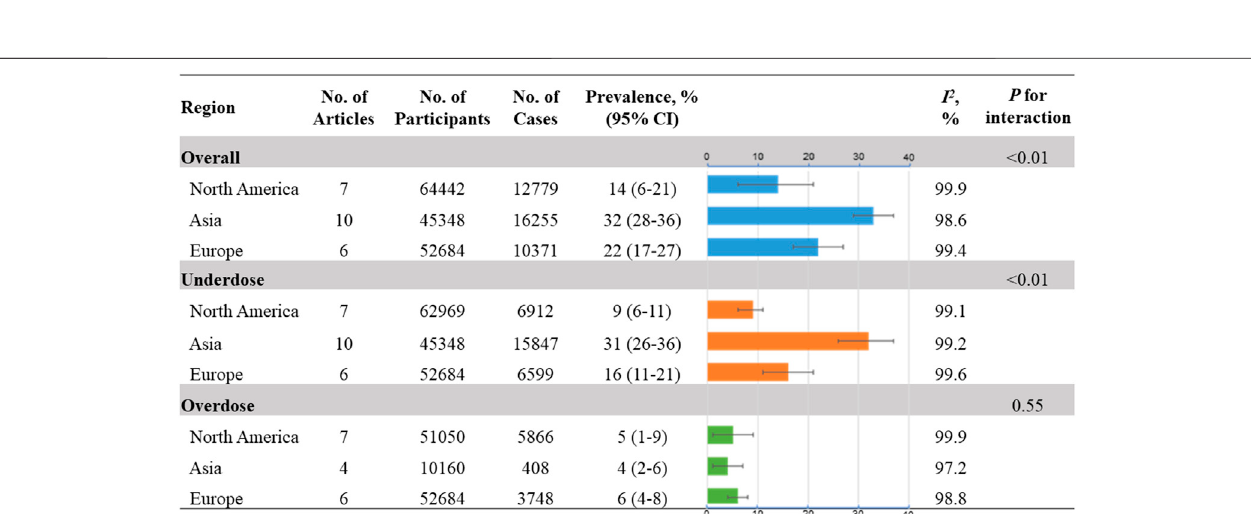
Frontiers in Pharmacology |